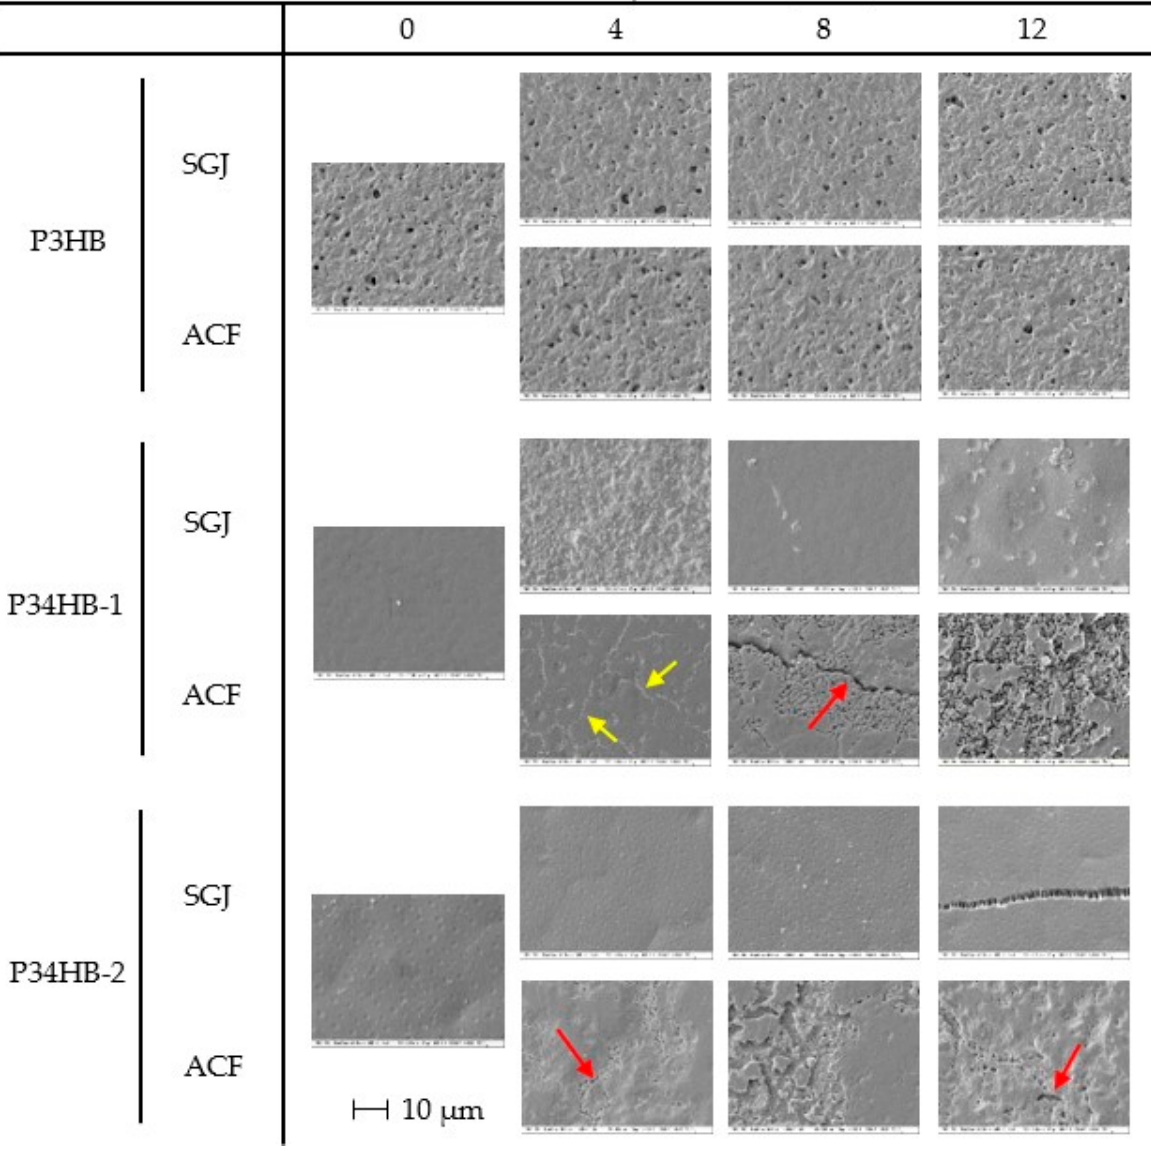
Figure 3. SEM micrographs showing surface morphology changes during incubation in SBFs.